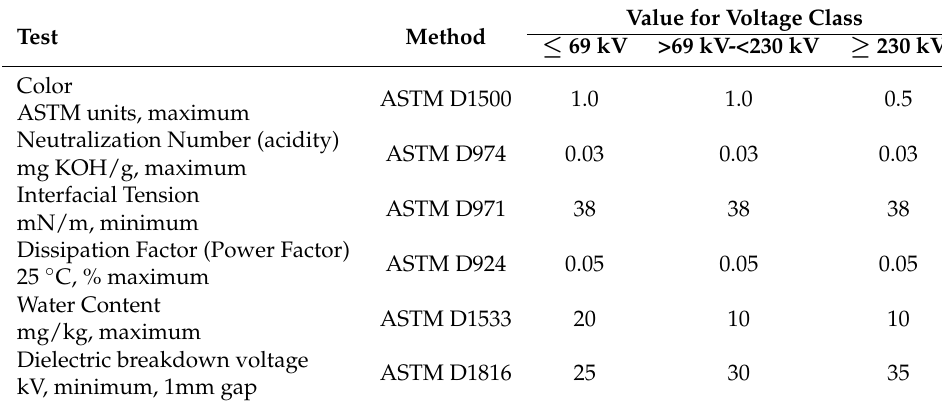
Table 1. Test limits for new insulating mineral oil (IMO received in new equipment or after filling, prior to energization